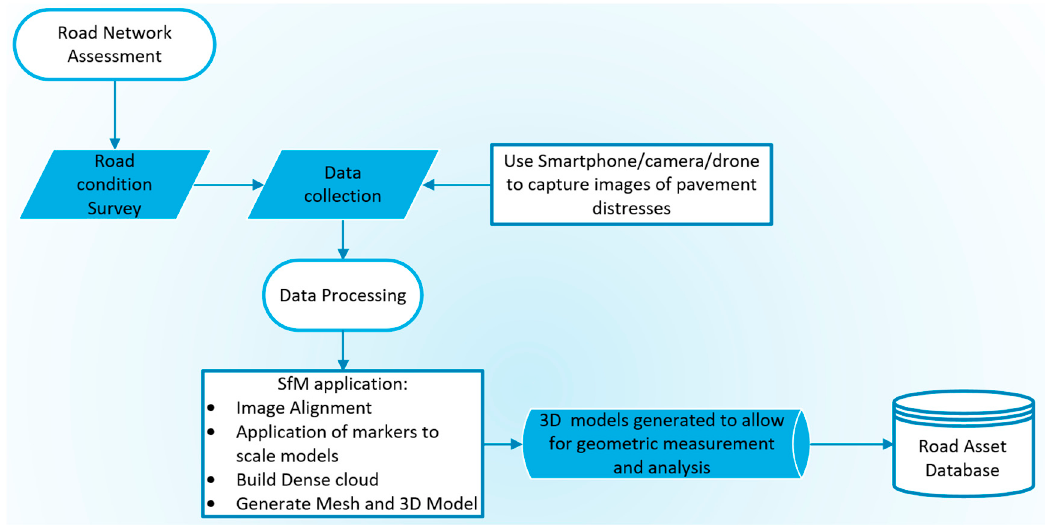
Figure 3. Typical SfM pipeline for generating pavement distress models.